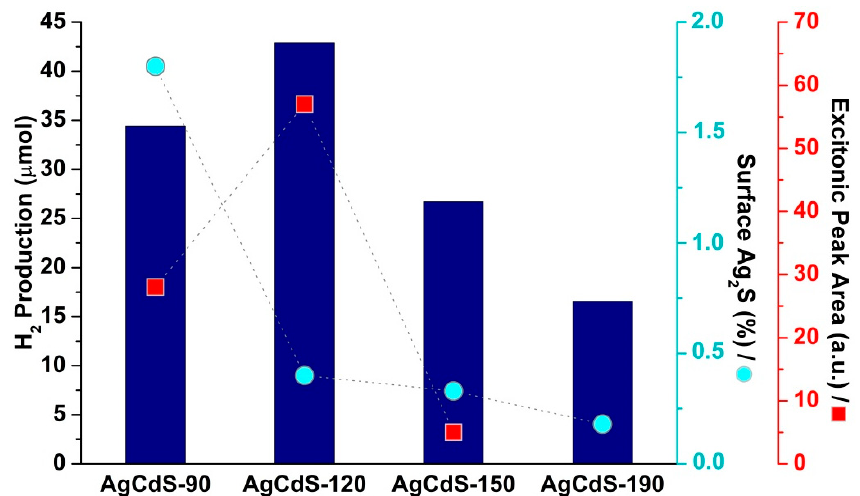
Figure 9. Relationship between hydrogen production for AgCdS-T respect to the Ag 2 S surface concentration (●) and concentration of quantum dots ( ■ ).